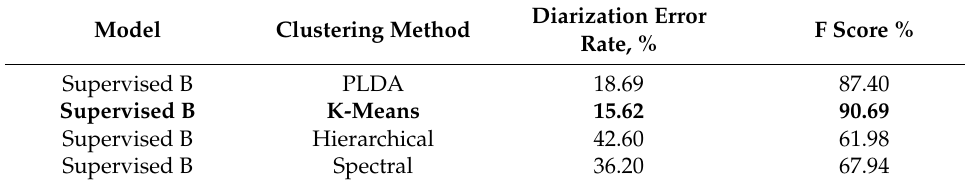
Table 2. Experiment 2 results.